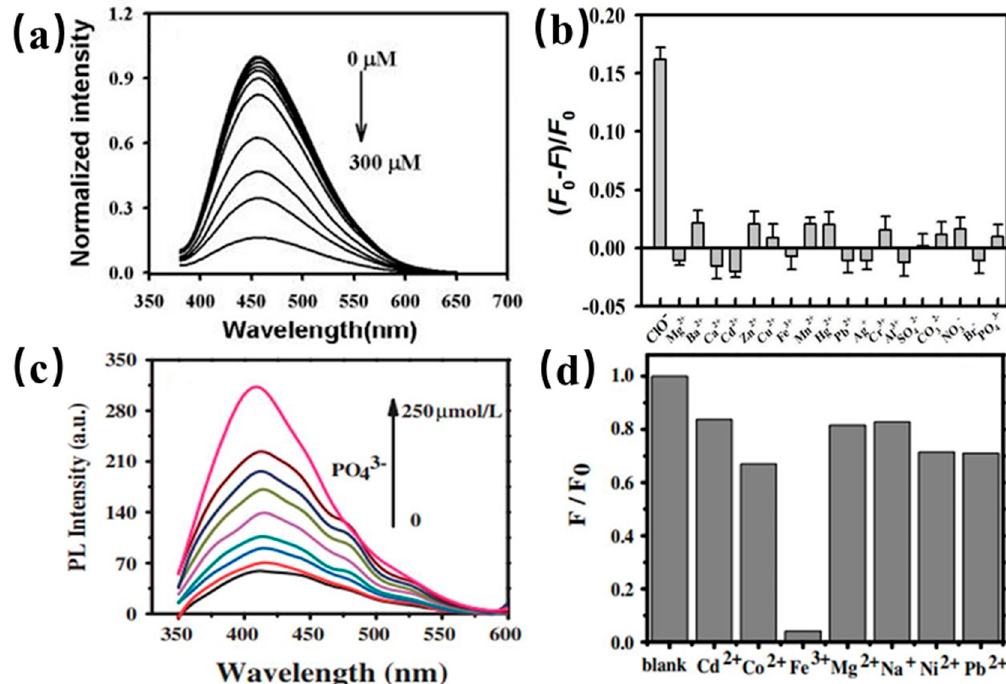
Figure 19. ( a ) FL response of BCDs dispersion in the presence of various concentrations of NaClO, and ( b ) Selectivity of the BCDs-based sensor for hypochlorite solution [110]. Copyright 2013, Royal Society of Chemistry. ( c ) PL emission of BCDs in the presence of various concentrations of PO 43 − , and ( d ) selectivity of the BCDs with different ions [151]. Copyright 2014, John Wiley and Sons.